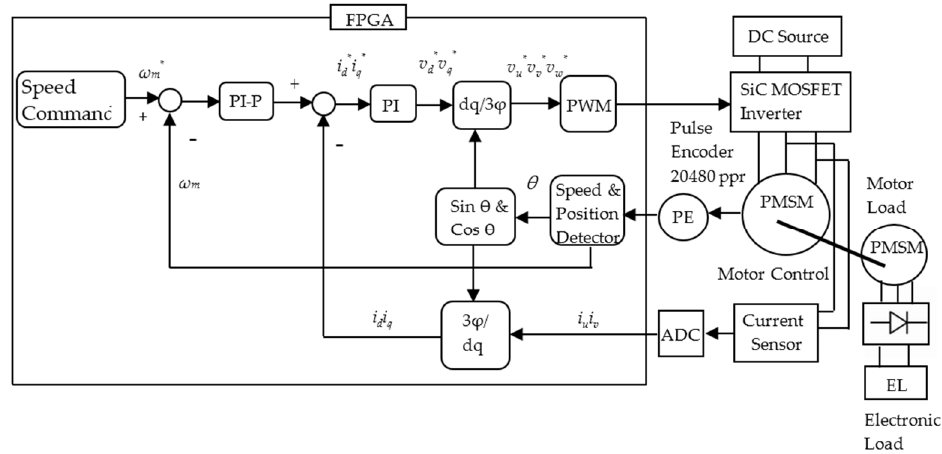
Figure 5. Block diagram of the PMSM (permanent magnet synchronous motor) speed control.